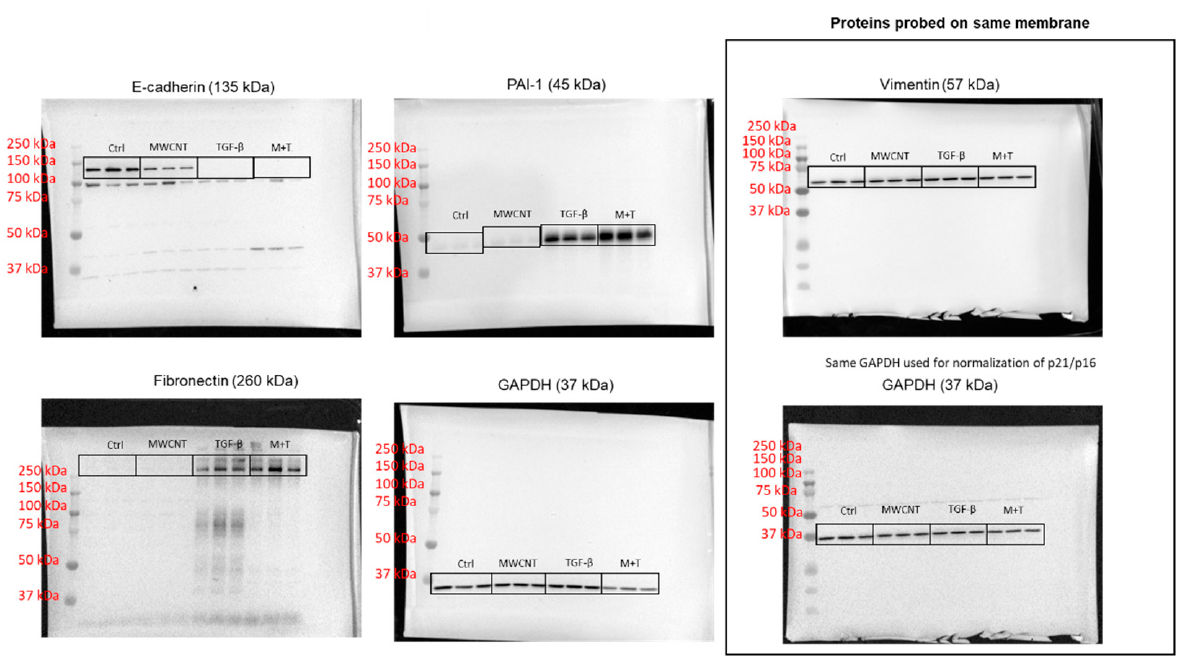
Figure A1. Full unedited gel for Figure 2